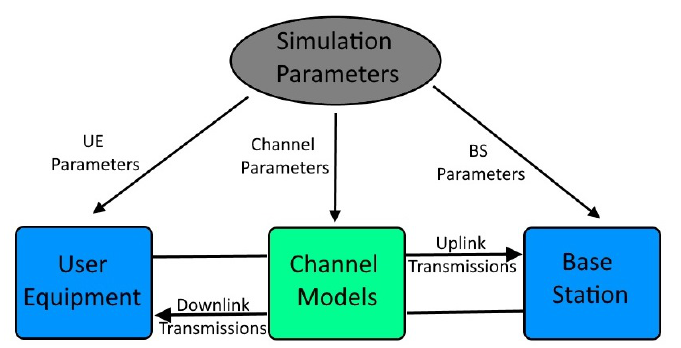
Figure 3. Our 5G simulator software